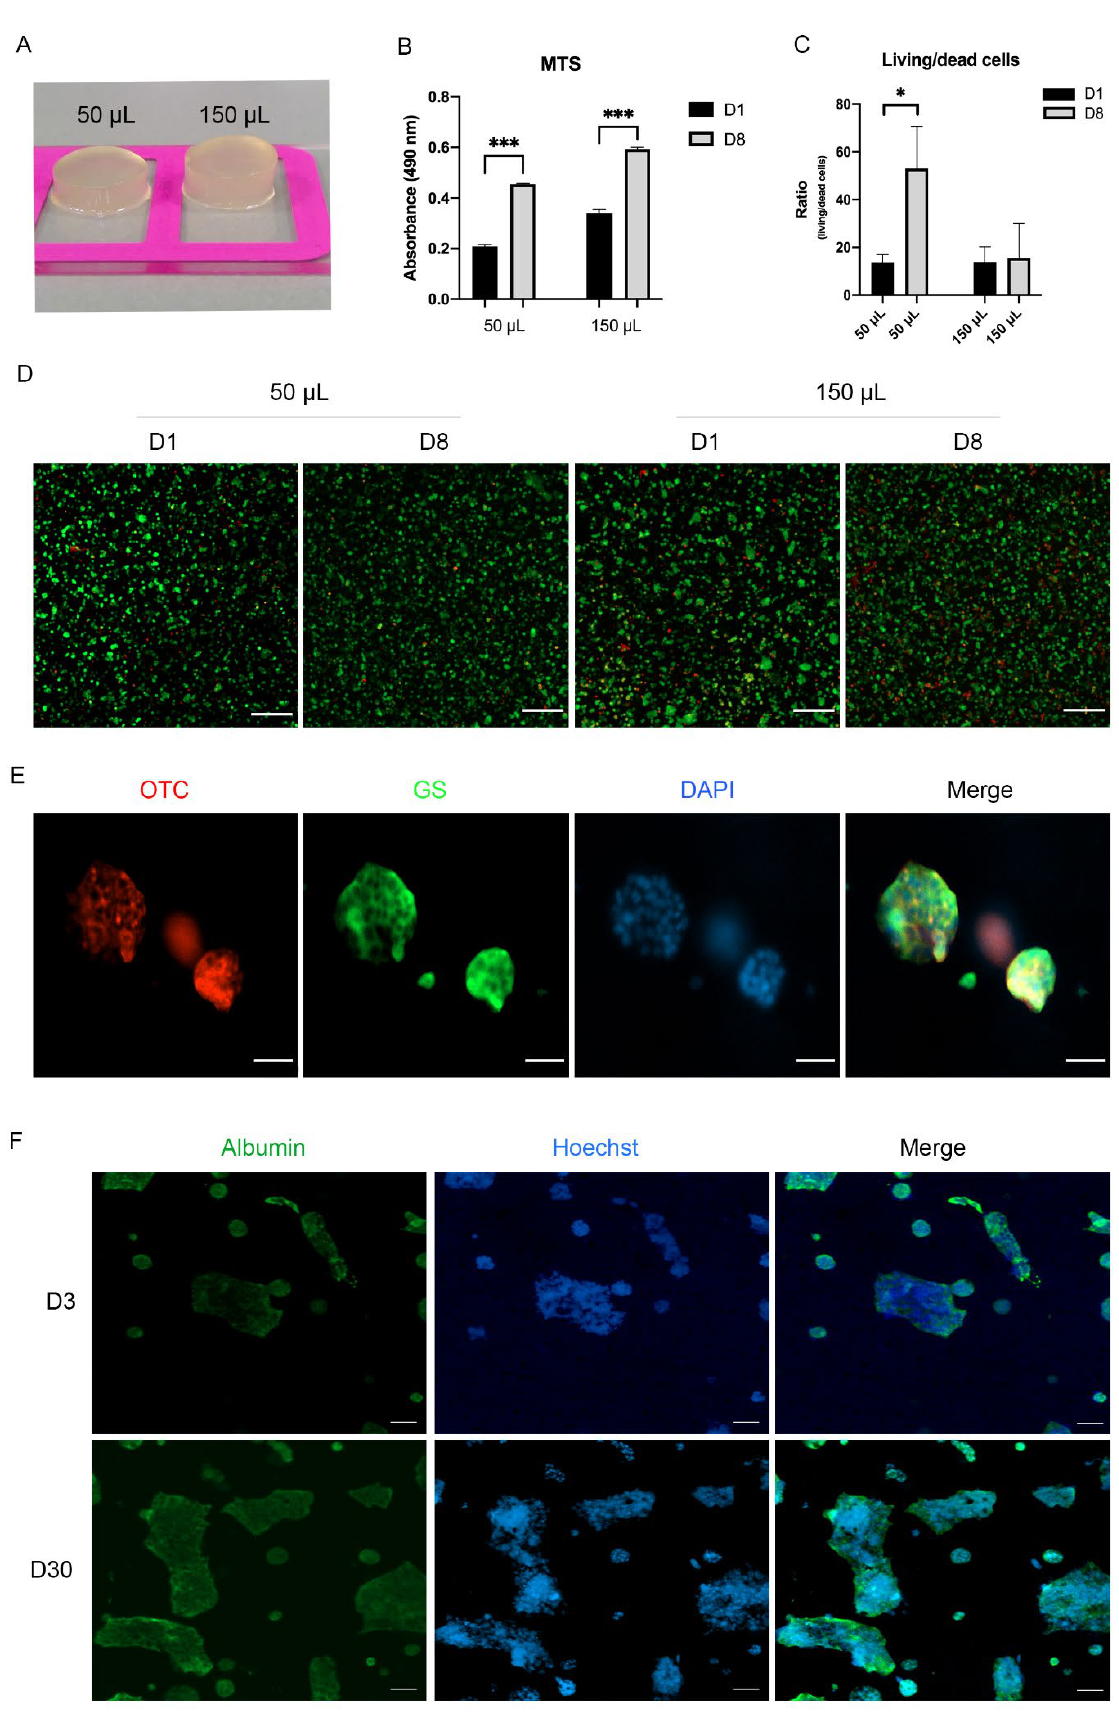
Figure 3. AML12 cell growth in 3D using GelMA-CMCMA polymer. ( A ) Picture of AML12